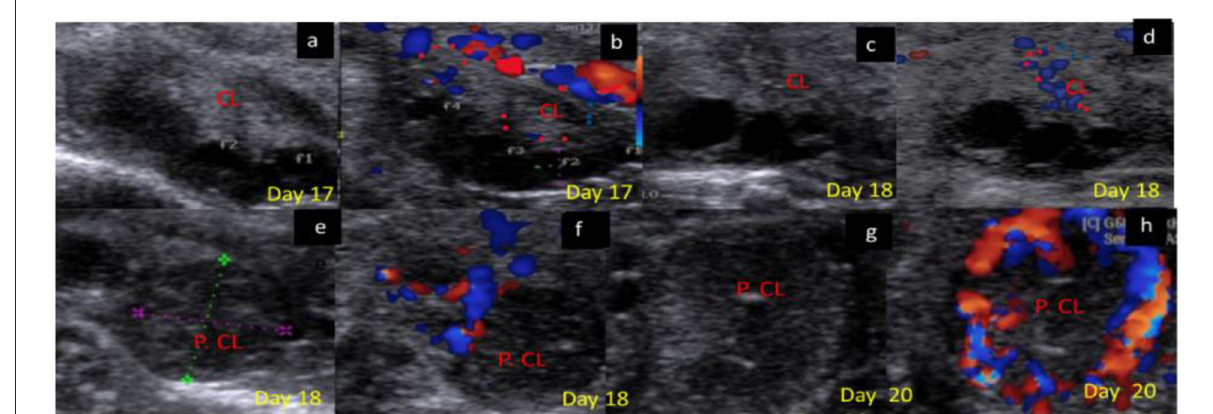
FIGURE6 B-mode and colored ultrasonograms of 9-year-old buffalos at the late luteal in non-pregnant compared to pregnant one (Stage IV vs. Stage I suspected pregnant from 17 to 20 days). As (a,b) images showed the regressed corpus luteum on day 17 in gray and color modes and (c,d) images showed the more regressed corpus luteum on day 18 in gray and color modes compared to (e,f) images showed the corpus luteum in suspected pregnant females on day 18 in gray and color modes, and (g,h) images showed the corpus luteum in suspected pregnant females on day 20 in gray and color modes. CL, corpus luteum.